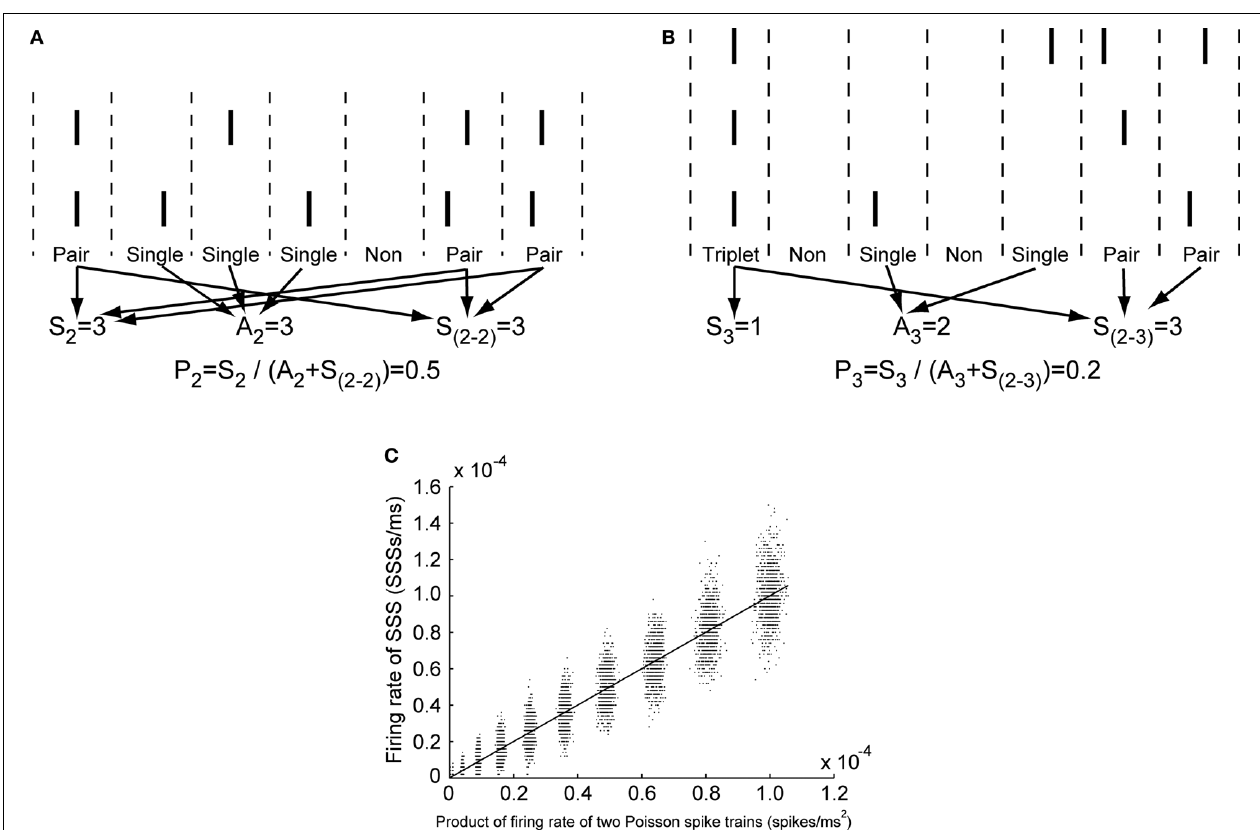
A stands for the number of windows in which only one neuron fi res. S 3 the number of windows in which two or three neurons fi re simultaneously. P represents the occurrence probability of SSS among those three spike trains. Each bar is one spike. Windows are partitioned by dashed lines. (C) The fi ring rate of SSSs between two Poisson spike trains is plotted as a function of the product of fi ring rate of those Poisson spike trains. The correlation coeffi cient, R , is 0.97. 3 The solid line depicts a linear regression line. The regression coeffi cient is